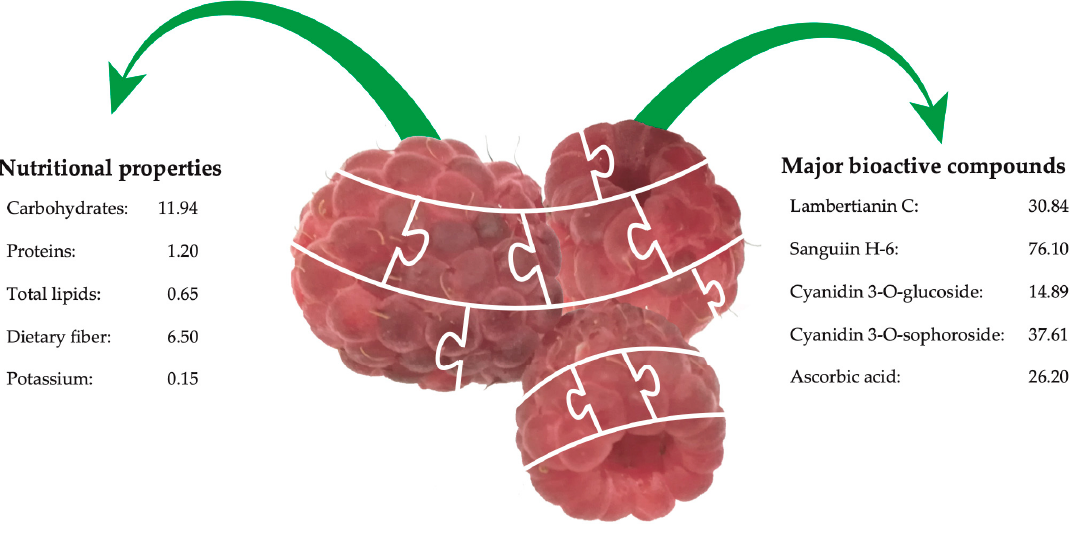
Figure 1. Nutritional (g 100 g − 1 ) and major bioactive compounds (mg 100 g − 1 ) in raw red raspberry fruits. Values were obtained from ‘Phenol Explorer Database’ and the literature